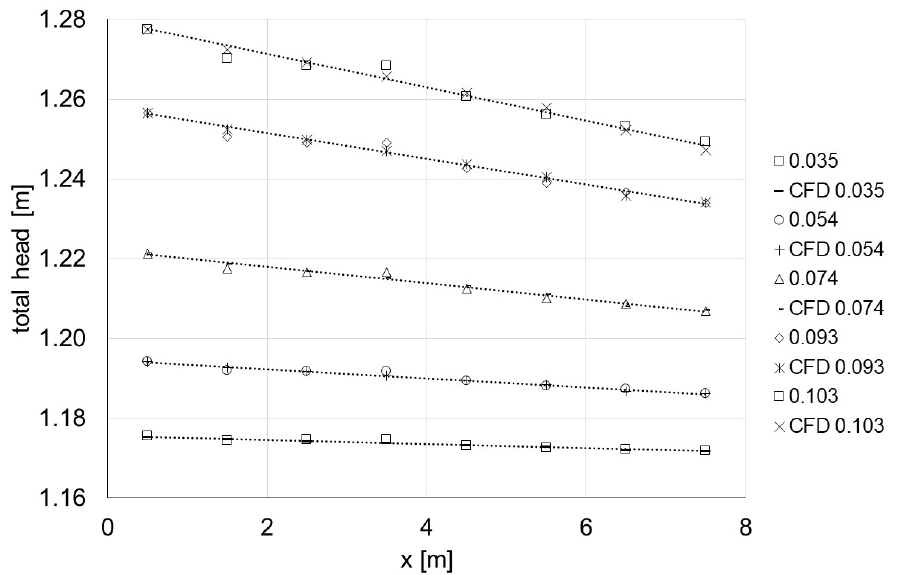
Figure 10. Comparison of total head estimates from the scale model measurements (open symbols) with the results from the numerical model (markers; α = 1). The solid line indicates the linear regression of the numerical data. The numbers in the legend indicate the discharges (in m 3 /s).